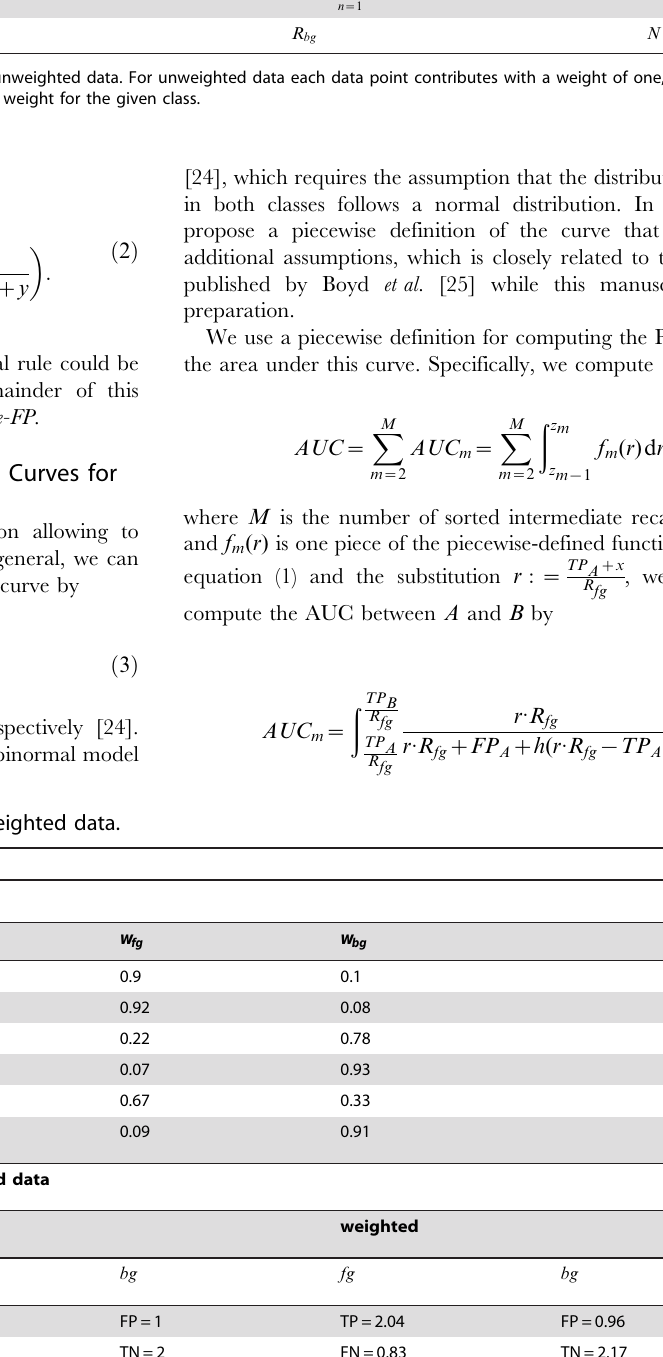
predicted label